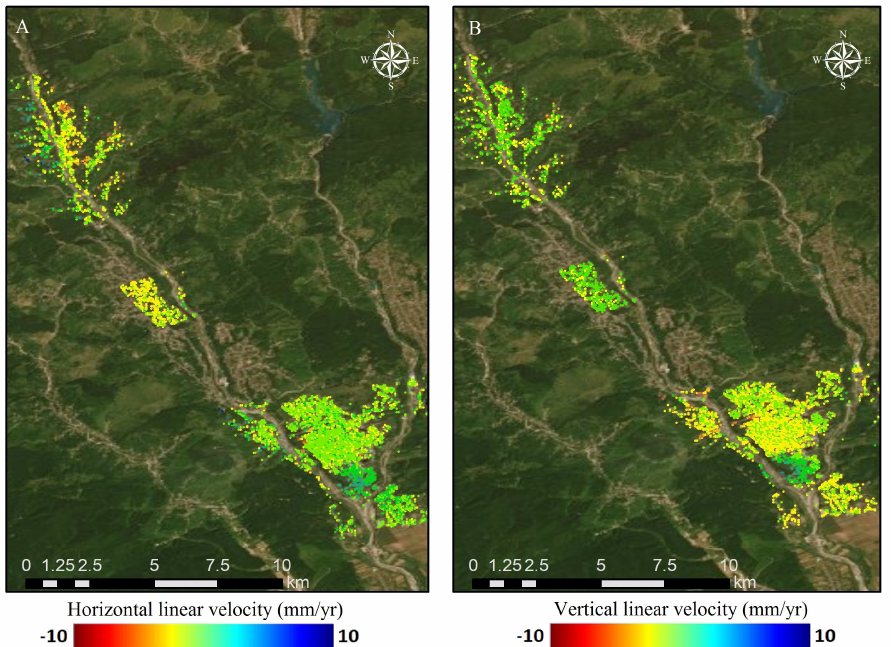
Figure 7. Decomposition of vertical velocity values on horizontal ( A ) and vertical axes ( B ) for three areas of the Subcarpathian Prahova Valley (velocity units in mm/yr). In Figure 7A, negative values depict movement towards the west, while positive values show movement towards the east. In Figure 7B, negative values correspond to vertical subsidence while positive values represent vertical uplift.